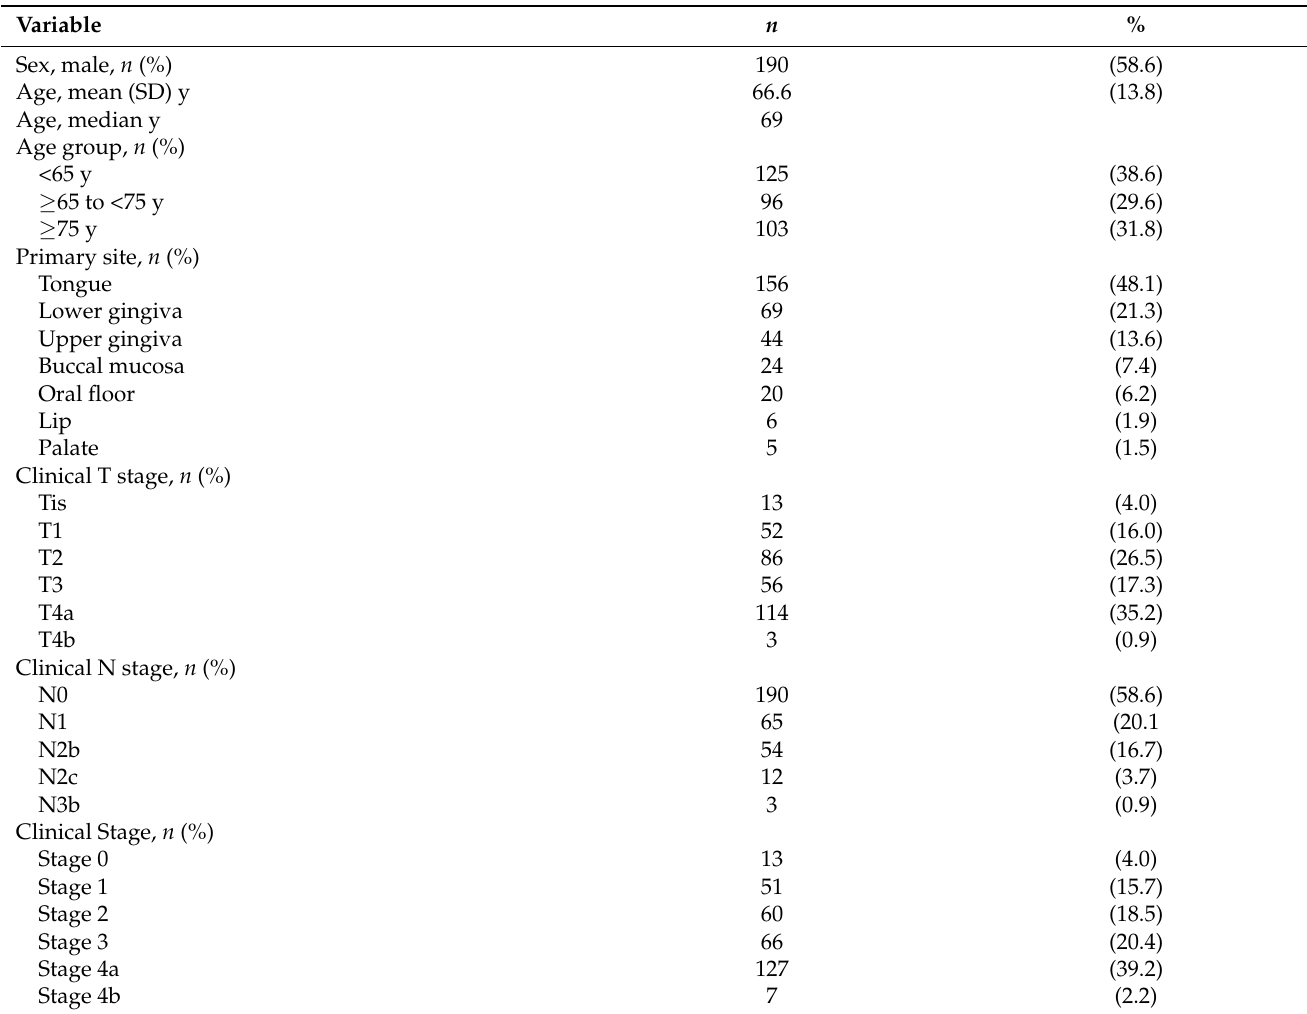
Table 1. Characteristics of patients with OSCC who were treated surgically ( n =